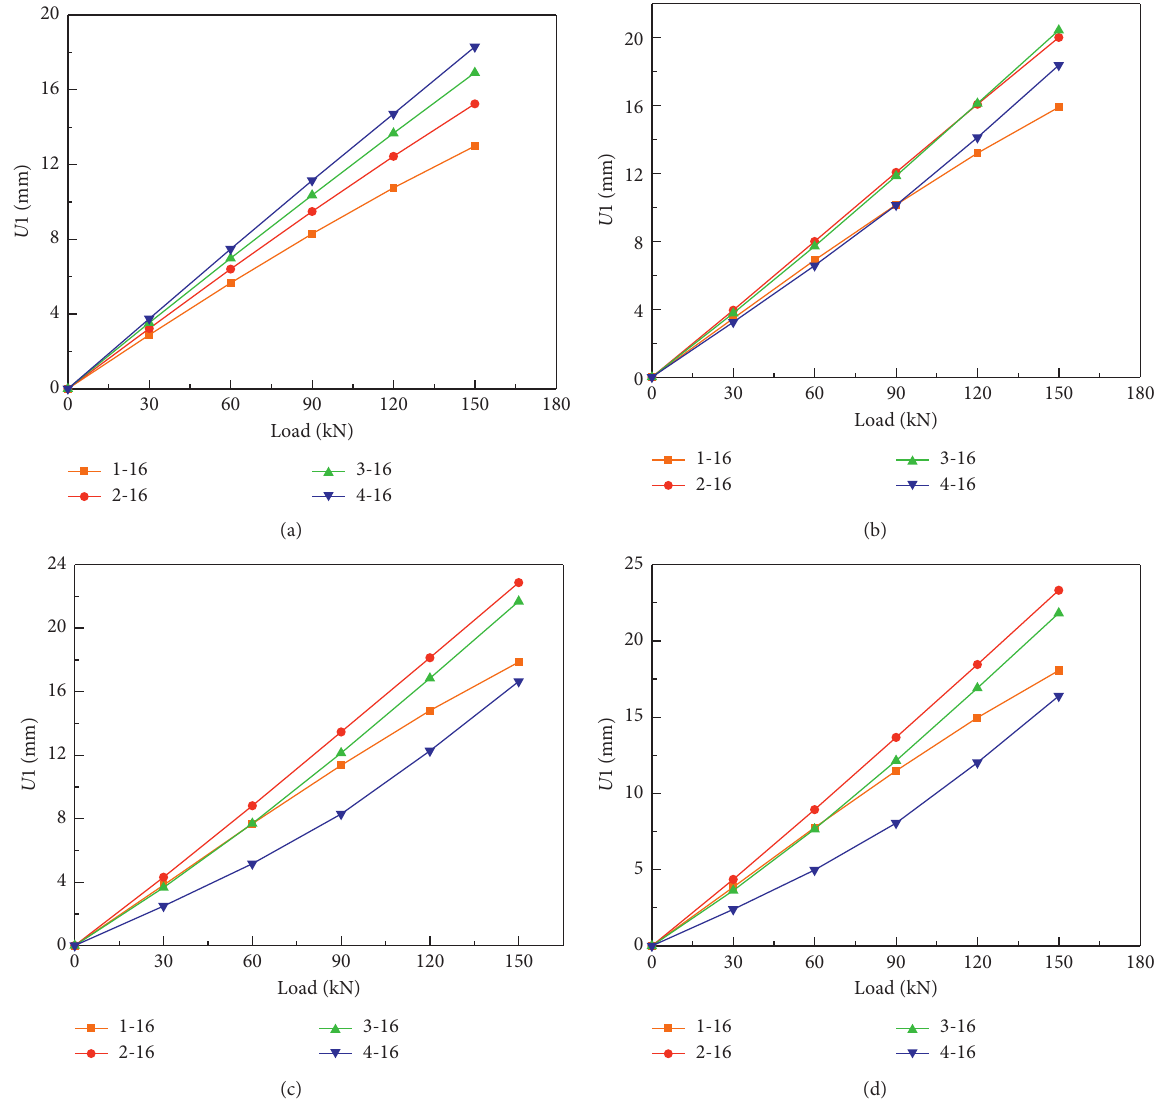
Figure 10: U1: (a) P1; (b) P3; (c) P5; (d)